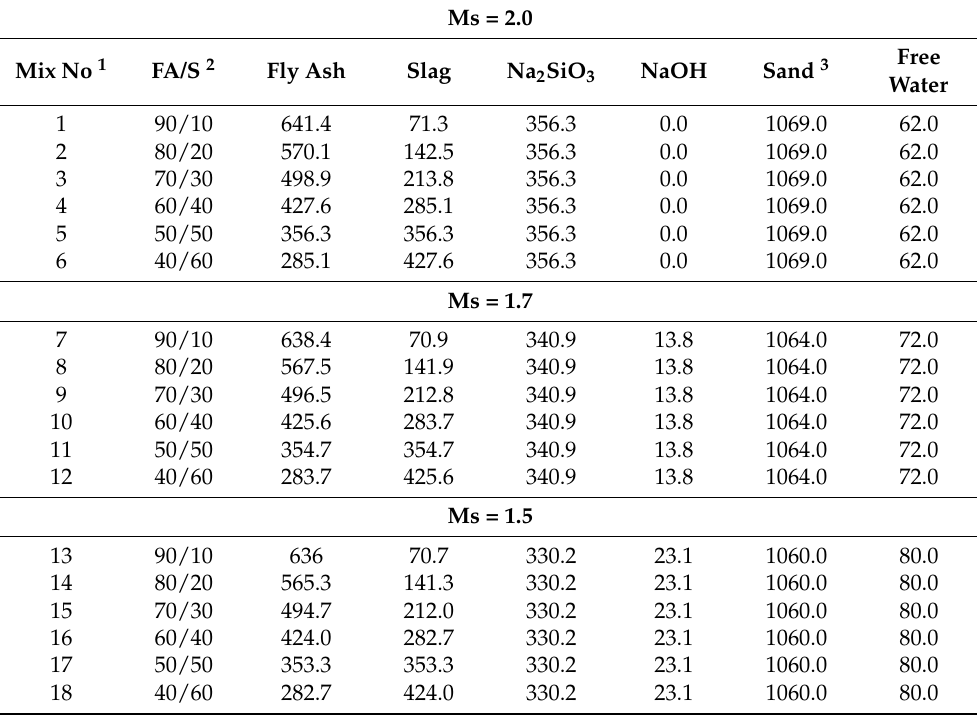
Table 3. Geopolymer mortar mix proportions